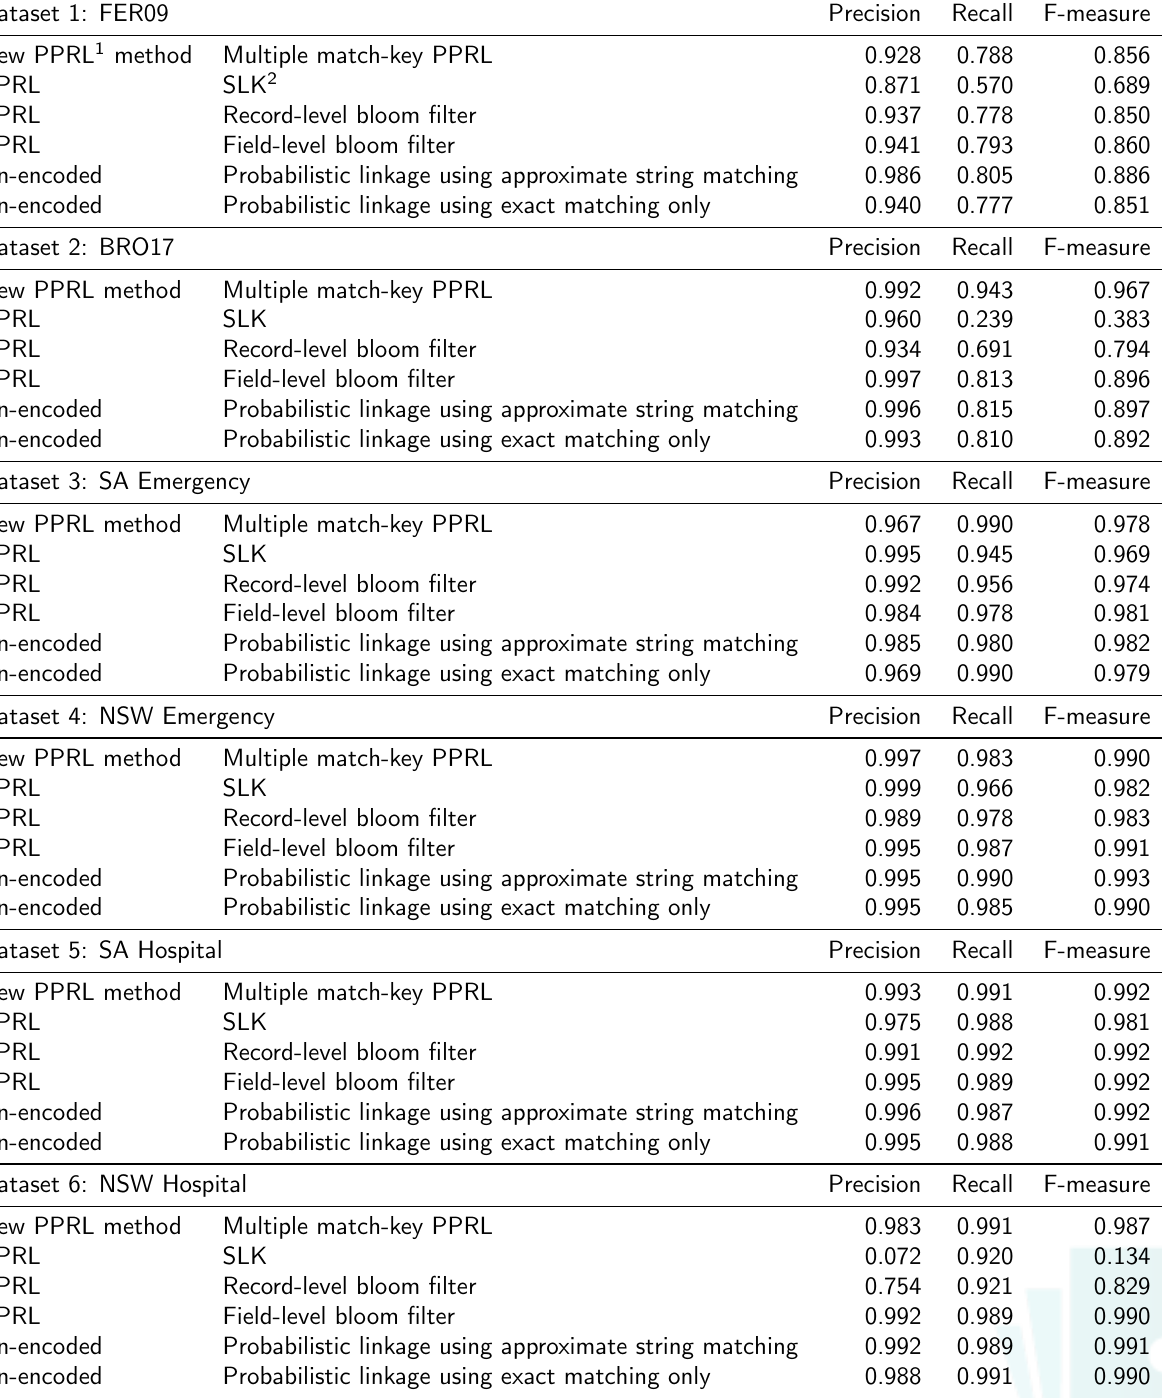
Table 4: Results from linkage quality